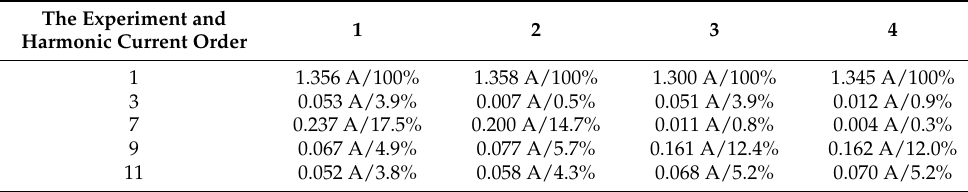
Table 3. Harmonic current suppression